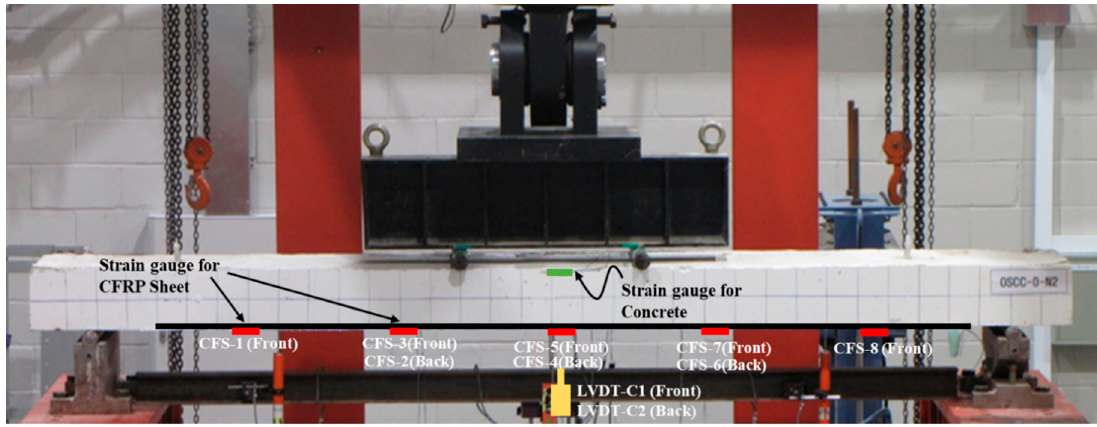
Figure 3. Test setup.